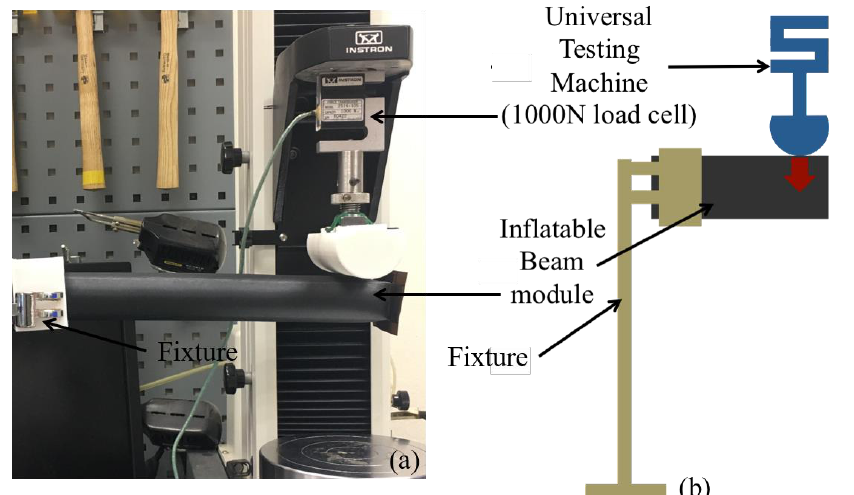
Figure 3. Photo ( a ) and illustration ( b ) of deflection–load test set-up for the IB module.